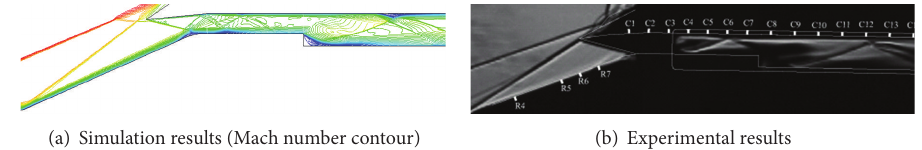
Figure 2: Comparison between Mach number contour and Schlieren pictures of a started inlet.